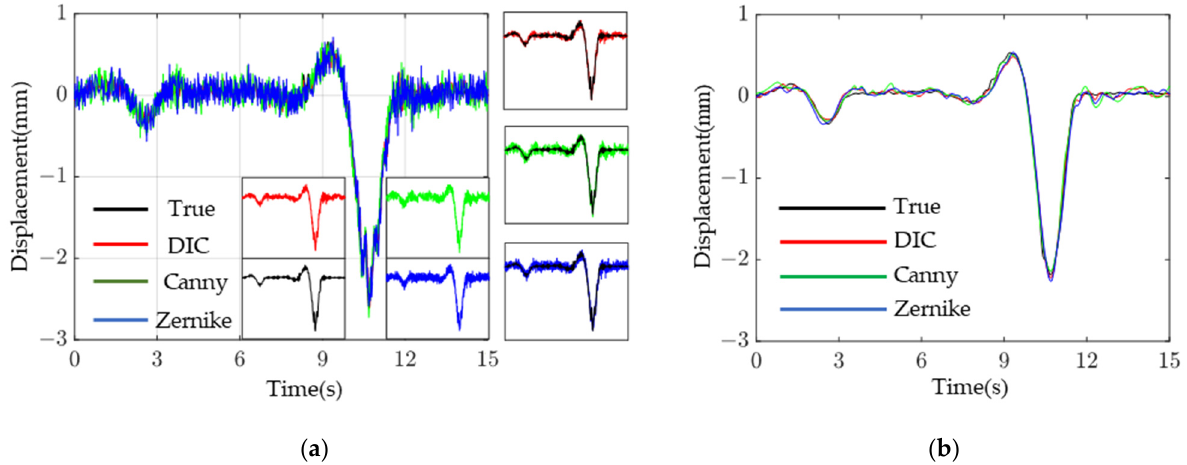
Figure 12. Displacement time history curve: ( a ) before EMD filtering; and ( b ) after EMD filtering.